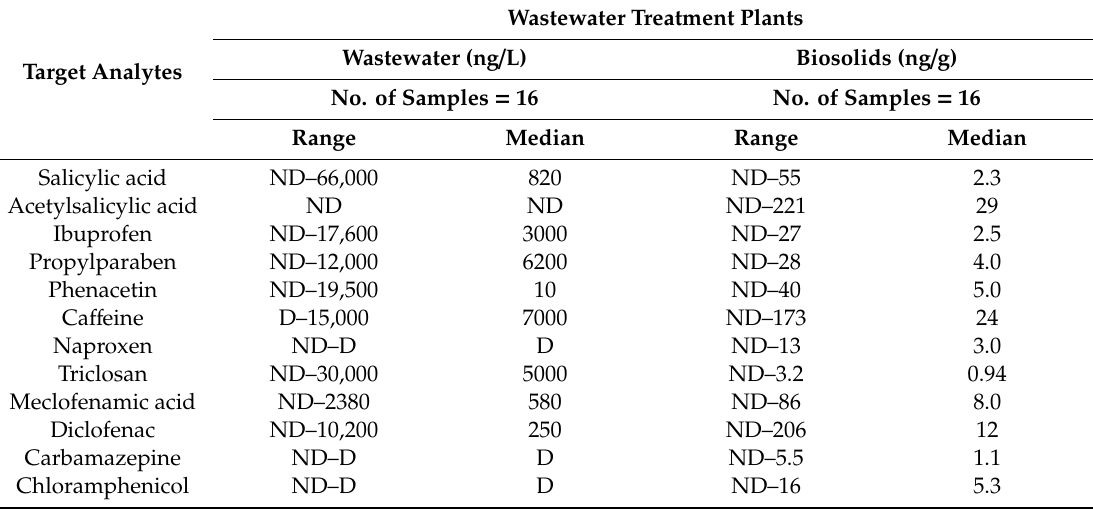
Table4. Quantificationoftargetcompoundsinwastewaterandbiosolidsatwastewatertreatmentplants.